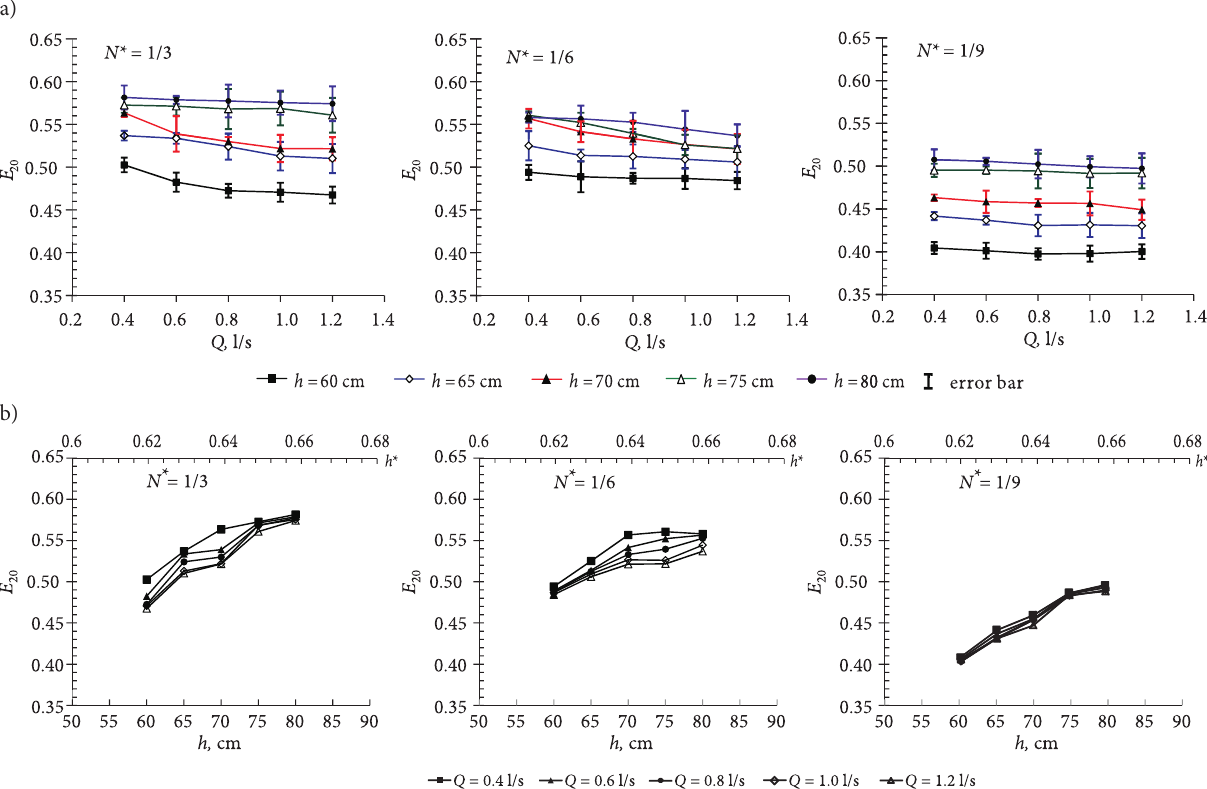
in interlaced flashboard spillways: (a) E 20